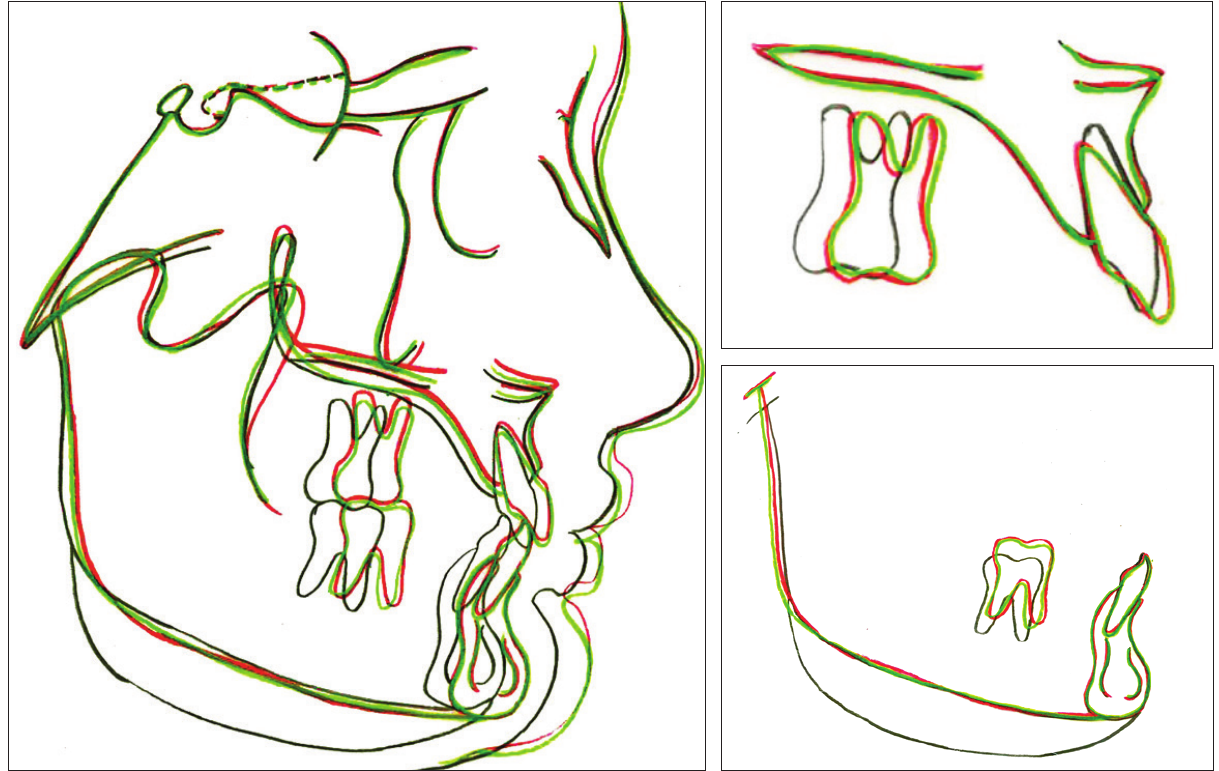
Figure 5b. Pre- to post-treatment to seven-year follow-up